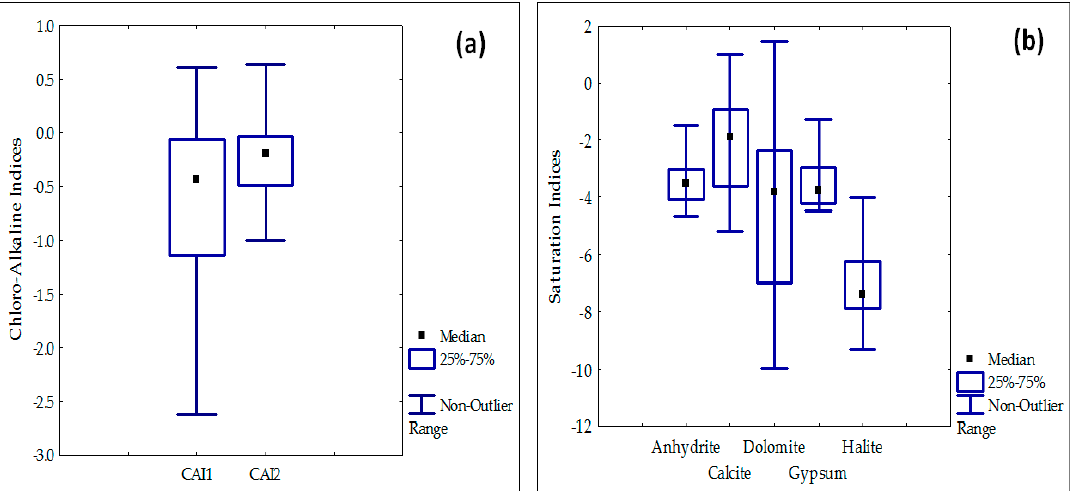
Figure 7. Chloro-Alkaline Indices ( a ) and Saturation Indices ( b ) of the groundwater samples.